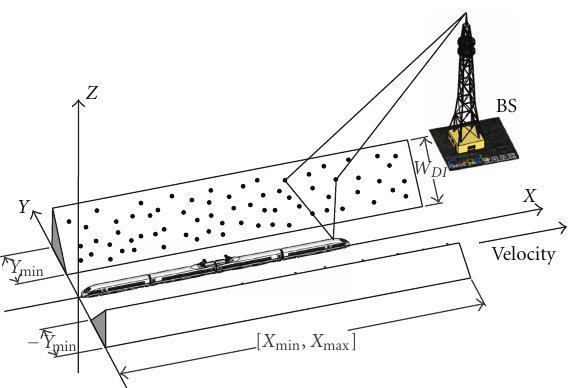
Figure 2: The channel model in terrain